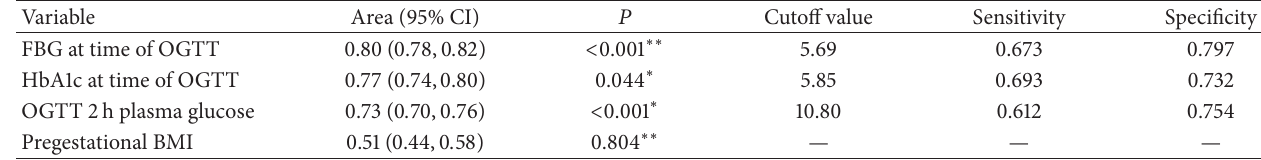
∗ Curve area compared with FBG at time of OGTT; ∗∗ curve area compared with